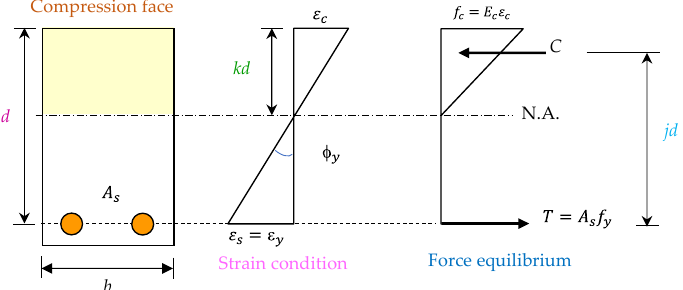
Figure 22. The stress and strain profiles of a typical reinforced concrete beam at the yielding state.